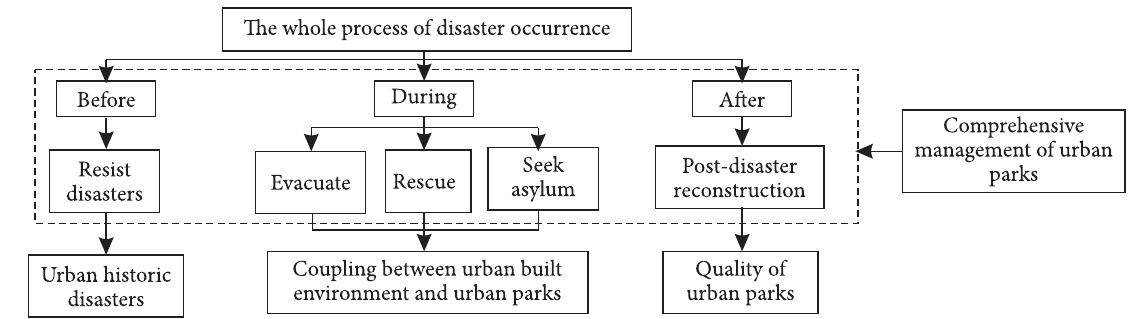
Figure 1. The framework of index system Table 1. Evaluation system for disaster prevention